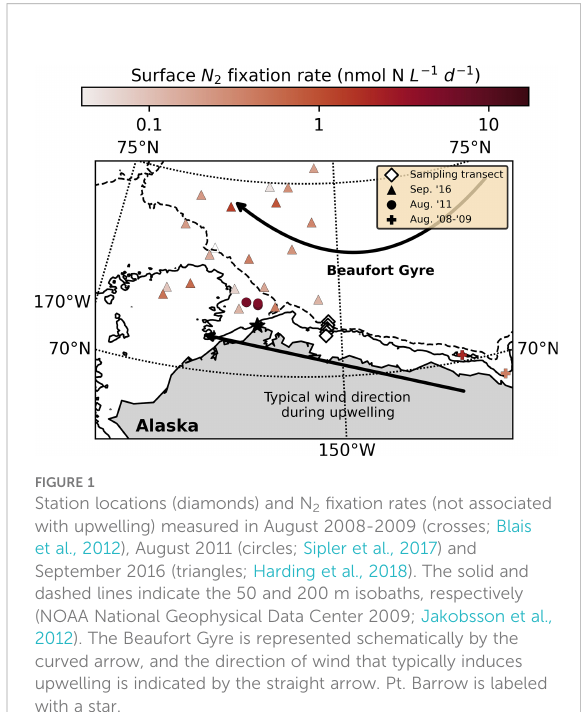
FIGURE 1 Station locations (diamonds) and N 2 fi xation rates (not associated with upwelling) measured in August 2008-2009 (crosses; Blais et al., 2012), August 2011 (circles; Sipler et al., 2017) and September 2016 (triangles; Harding et al., 2018). The solid and dashed lines indicate the 50 and 200 m isobaths, respectively (NOAA National Geophysical Data Center 2009; Jakobsson et al., 2012). The Beaufort Gyre is represented schematically by the curved arrow, and the direction of wind that typically induces upwelling is indicated by the straight arrow. Pt. Barrow is labeled with a